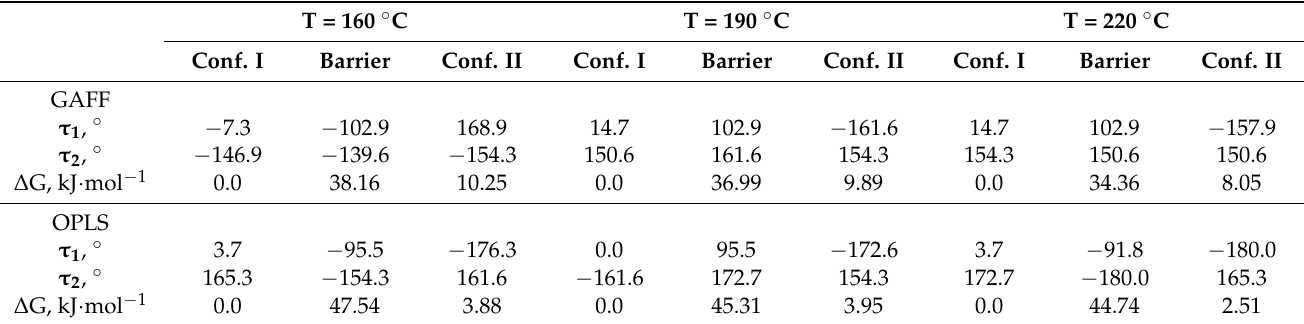
Figure 7. 2D Gibbs free energy maps in the coordinates of two dihedral angles τ 1 and τ 2 obtained using GAFF ( a ) and OPLS ( b ) force fields at 160 ◦ C for the MA molecule in scCO 2 . The symbols on the energy map show the MA conformer positions obtained from MD simulations ( Conf. I and Conf. II )—circles, and from QCC ( QCC Ia , QCC Ib and QCC IIa , QCC IIb )—squares. Table 4. Gibbs free energy values of two MA conformers and minimal energy barriers of the transition between them in scCO 2 calculated using GAFF and OPLS force fields at three temperatures.